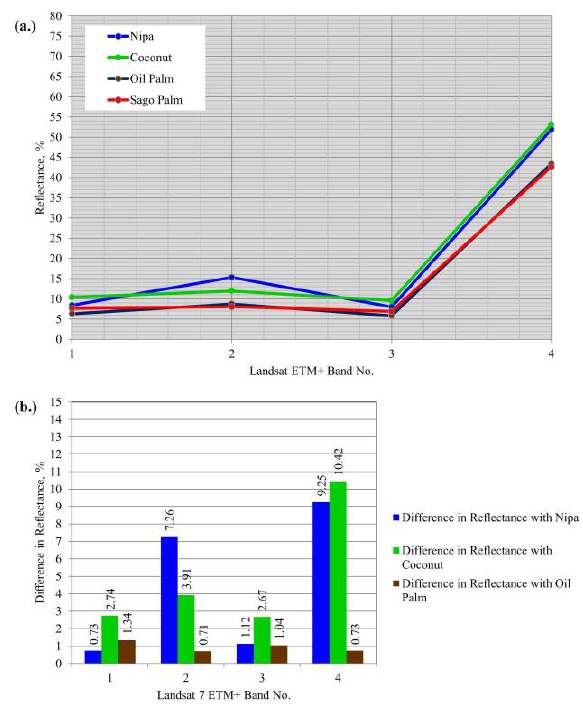
Figure 4. (a.) Resampled in-situ reflectance values of Sago and other palms in Bands 1-4 of Landsat 7 ETM+; (b.) Difference in resampled in-situ reflectance of Sago with those of other palms.